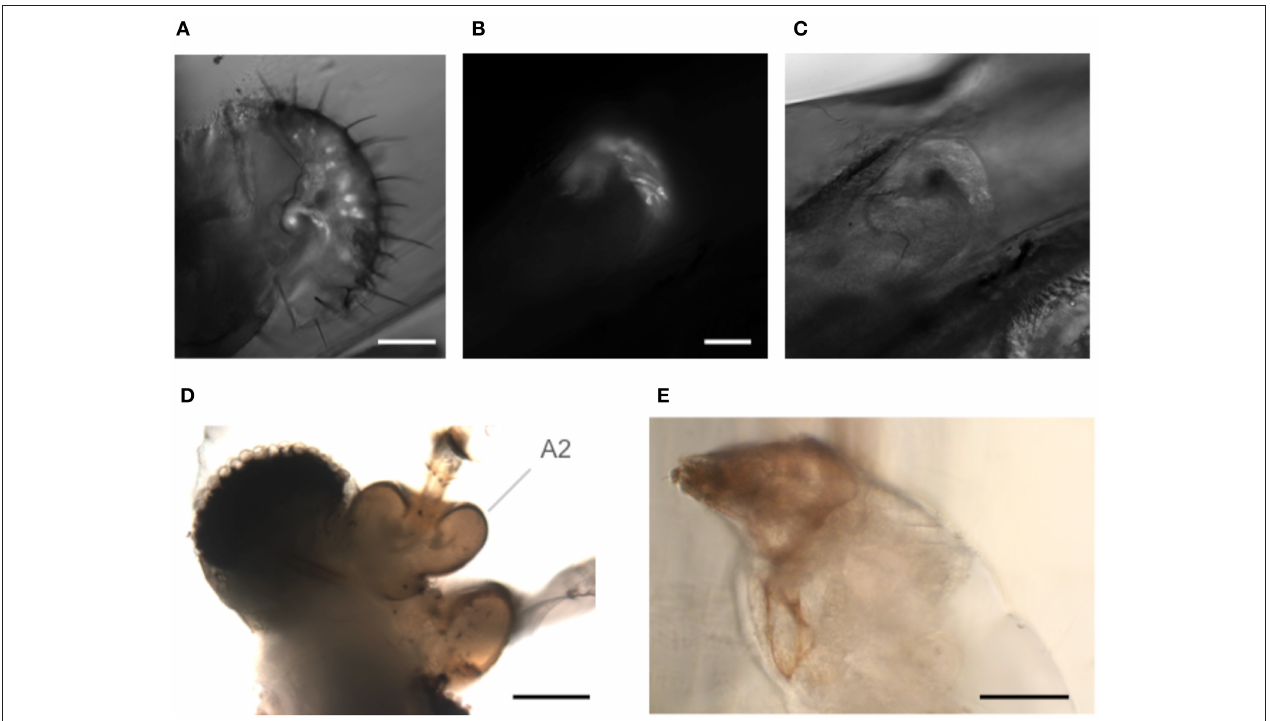
FIGURE 7 | Goggatomy of Drosophila and other arthropods. (A) Drosophila labellum, GFP, scale bar 50 µ m. (B,C) Drosophila leg chordotonal organ, GFP, scale bar 25 µ m. (B) Fluorescence and (C) bright field. (D) Mosquito head, Culex pipiens , scale bar 50 µ m. (E) Anterior end of Mimolette cheese mite, Acarus siro , scale bar 50 µ m. Head is top left. The mite was cut in spider saline ( Schmitz et al.,